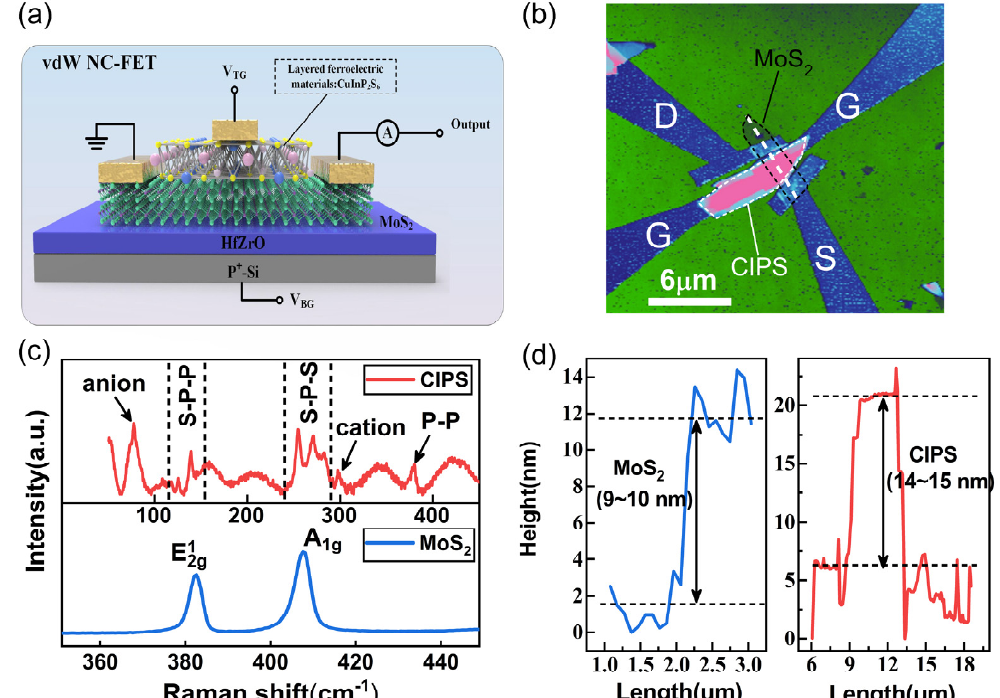
Figure 1. ( a ) The schematic diagram of the CIPS/MoS 2 vdW in-situ ferroelectric transistor. ( b ) The surface morphology of the CPIS/MoS 2 ferroelectric transistor, as measured by AFM. ( c ) The Raman spectrum of the exfoliated CIPS and MoS 2 flake. ( d ) The height distribution along the white dotted line in the AFM image.